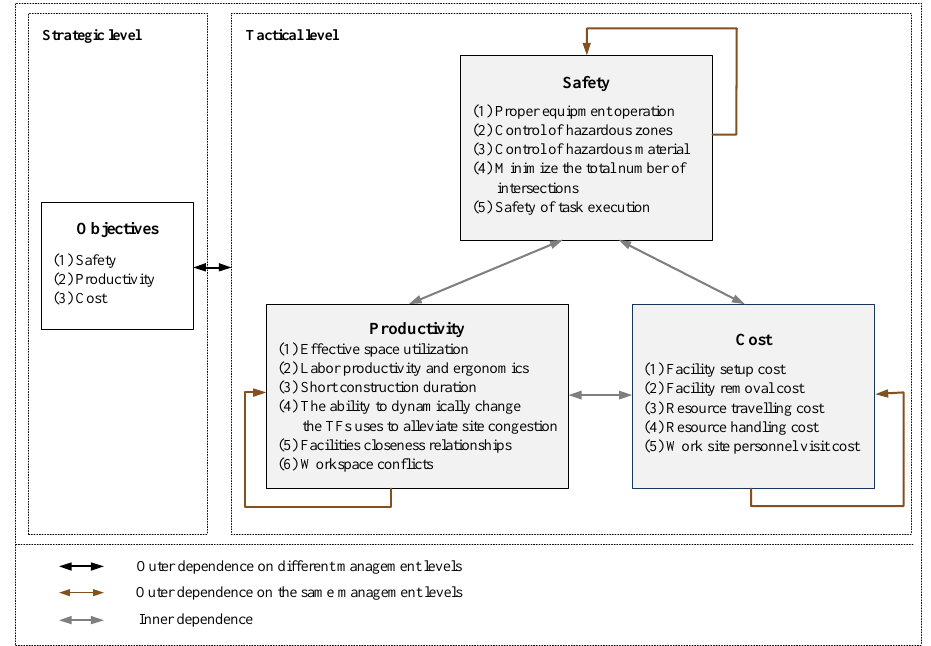
Figure 2. ANP network structure for temporary facility layout planning.